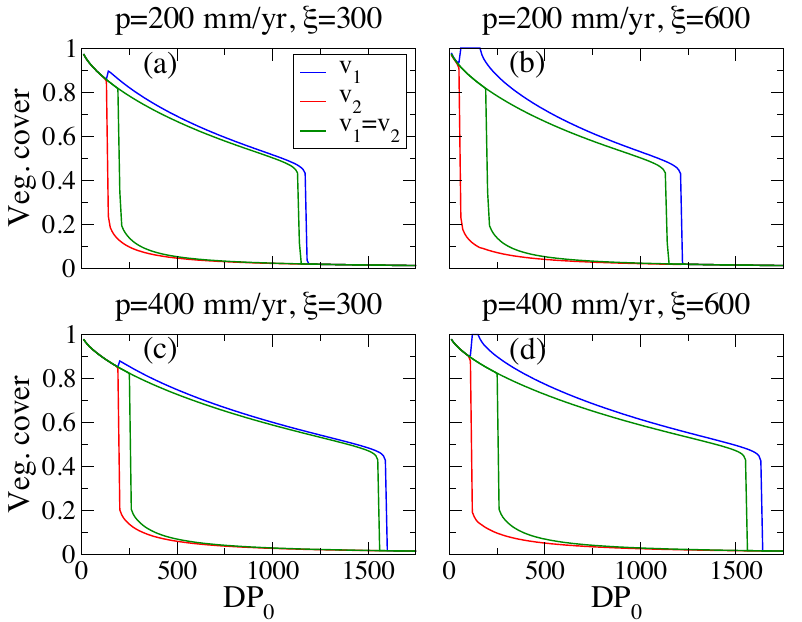
Figure 6. Vegetation cover as a function of background drift potential, DP 0 , obtained using the simple model for vegetation cover on sand dunes when the atmospheric (albedo) feedback was taken into account. The model’s steady states are plotted for different choices of precipitation, p , and albedo feedback, ξ , parameters: (a) p = 200 mm yr − 1 , ξ = 300, (b) p = 200 mm yr − 1 , ξ = 600, (c) p = 200 mm yr − 1 , ξ = 600, (d) p = 400 mm yr − 1 , ξ = 600. Parameters values: v c = 0.3, d = 15, A v = 0.1, A s = 0.4, η = 0.2, e = 10 − 3 , p min = 50 mm yr − 1 , c = 100 yr − 1 , α max = 0.15, γ = 8 10 − 4 , µ = 0 [see, 43].